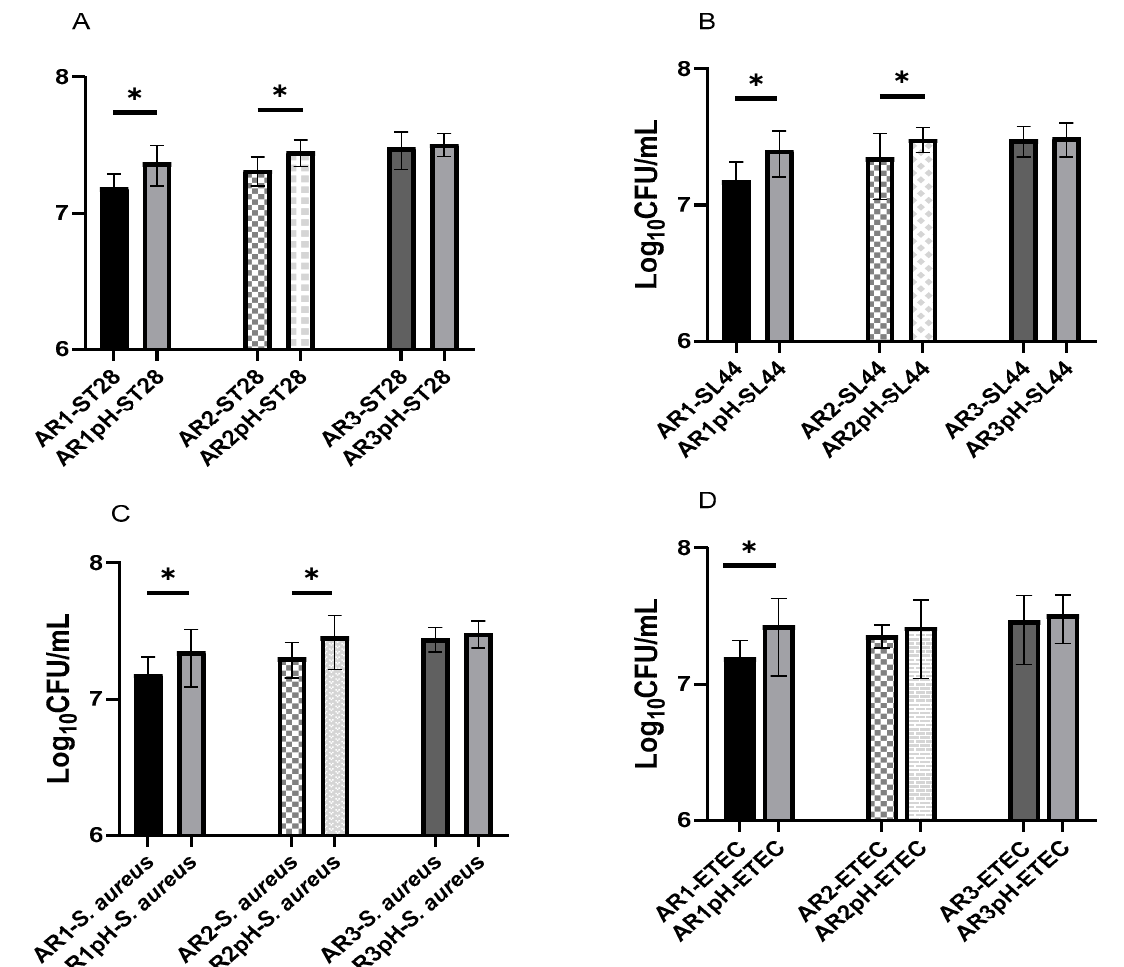
Figure 11. Viable count of S. Typhimurium ATCC14028 ( A ), S. Typhimurium SL1344 ( B ), S. aureus ( C ), and ETEC ( D ) after 12 h of growth in co-culture with Lactobacilli and low pH equal to the 24 h culture pH of Lactobacilli . Star (*) represents significant difference between the groups.